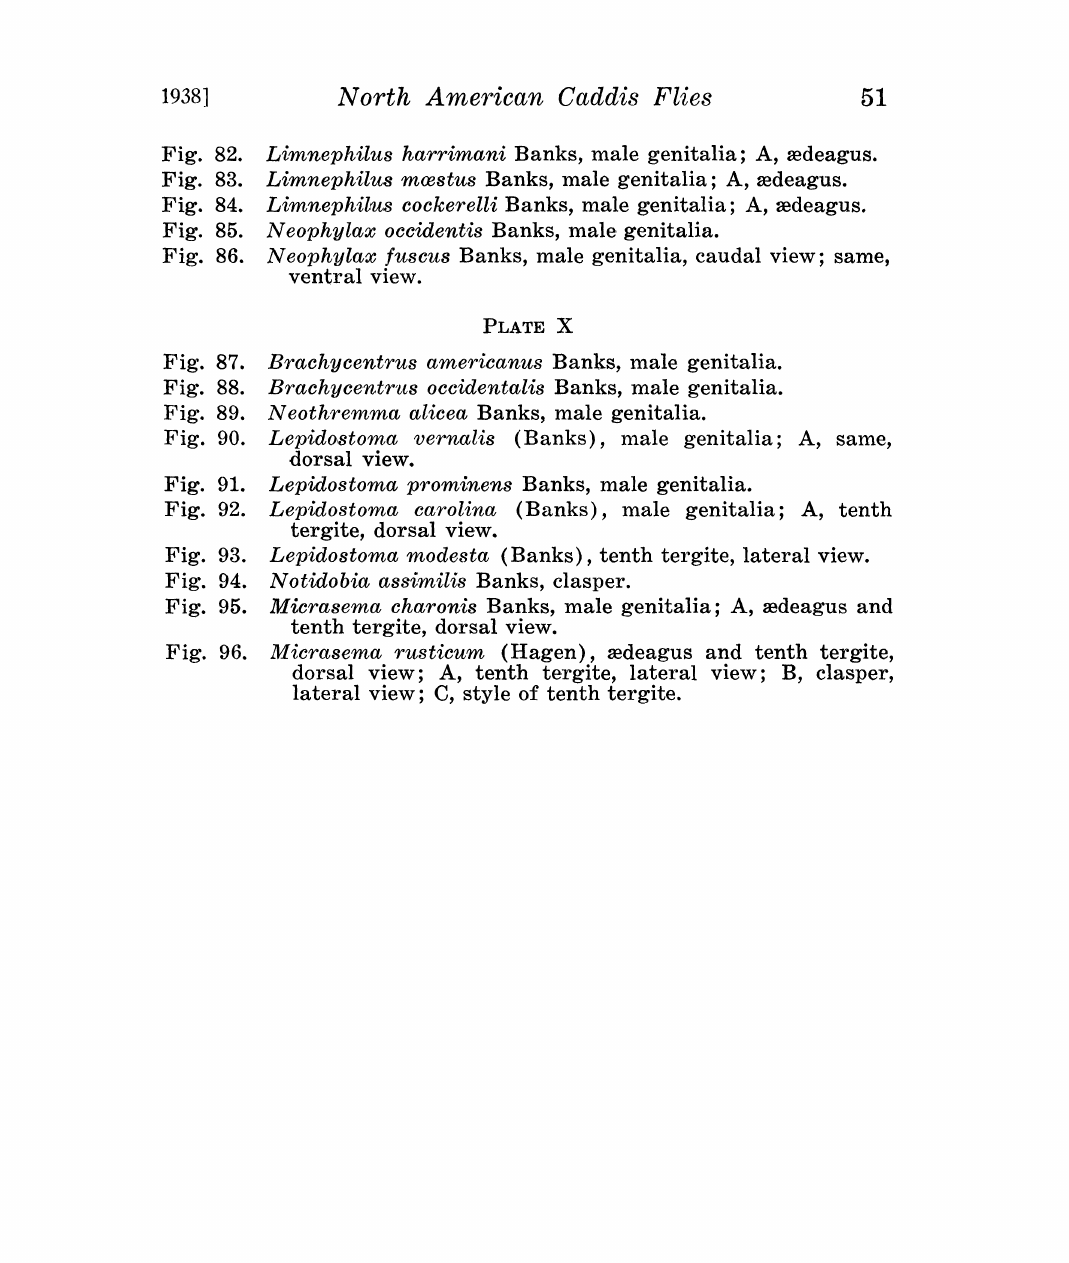
Limnephilus harrimani Banks, male genitalia; A, edeagus. Limnephilus moestus Banks, male genitalia; A, edeagus. Limnephilus cockerelli Banks, male genitalia; A, mdeagus. Neophylax occidentis Banks, male. genitalia. Neophylax fuscus Banks, male genitalia, caudal view; same, ventral view. PLATE 87. 88. 89. 90.